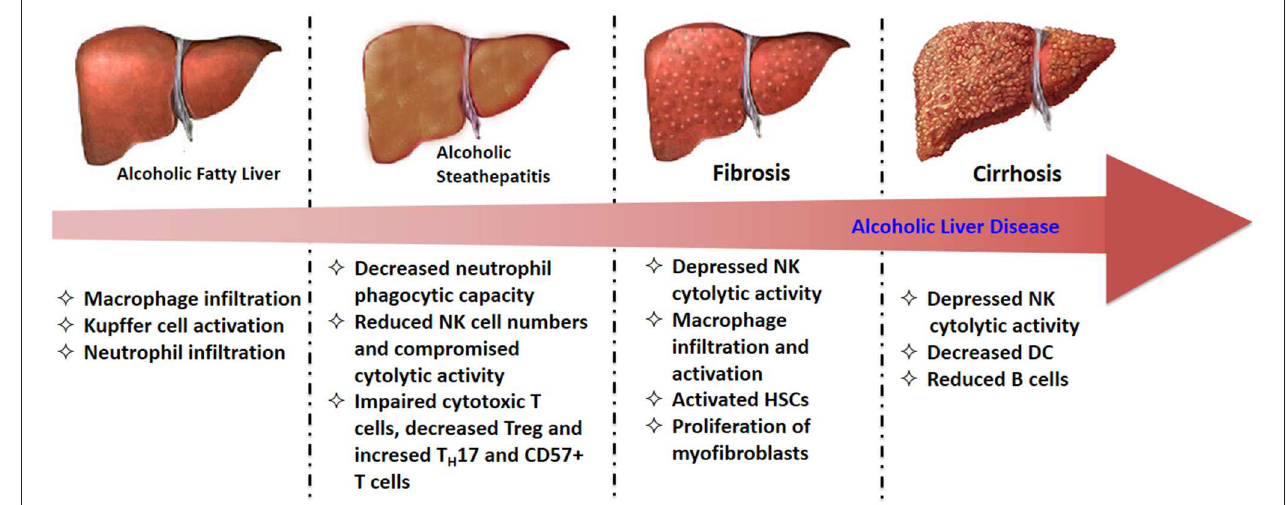
FIGURE 2 | The alterations of immune cells in diverse stages of